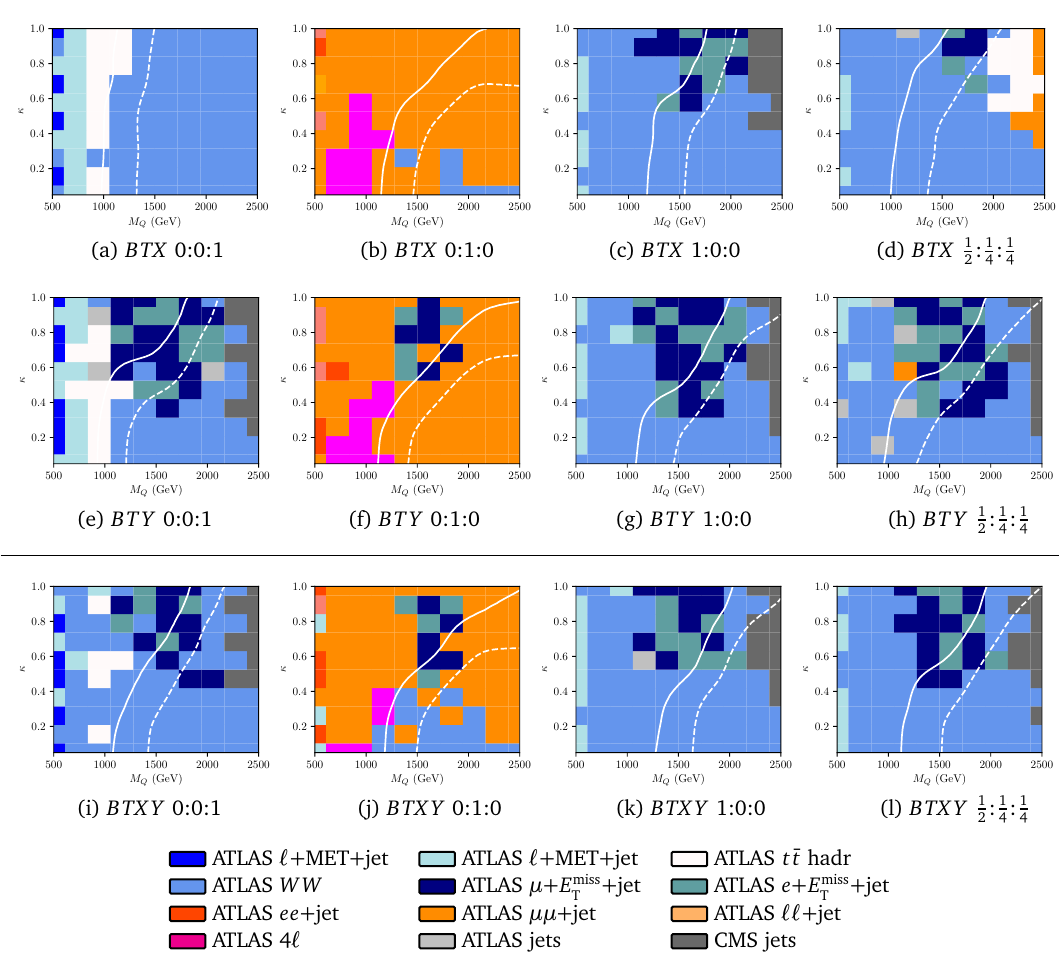
Figure 17: Sensitivity of LHC measurements to VLQ triplet production in the κ vs VLQ mass plane, where κ is the coupling to third-generation SM quarks. All VLQ masses are set to be degenerate. The multiplets are given as rows: (a)–(d)( B , T , X ) triplet, (e)–(h)( B , T , Y ) triplet, and for comparison to the main text, the (i)–(l)( B , T , X , Y ) quadruplet. The VLQ branching fractions to W : Z : H are arranged in columns of 0:0:1, 0:1:0, 1:0:0, and 1 : 1 : 1 from left to 2 4 4